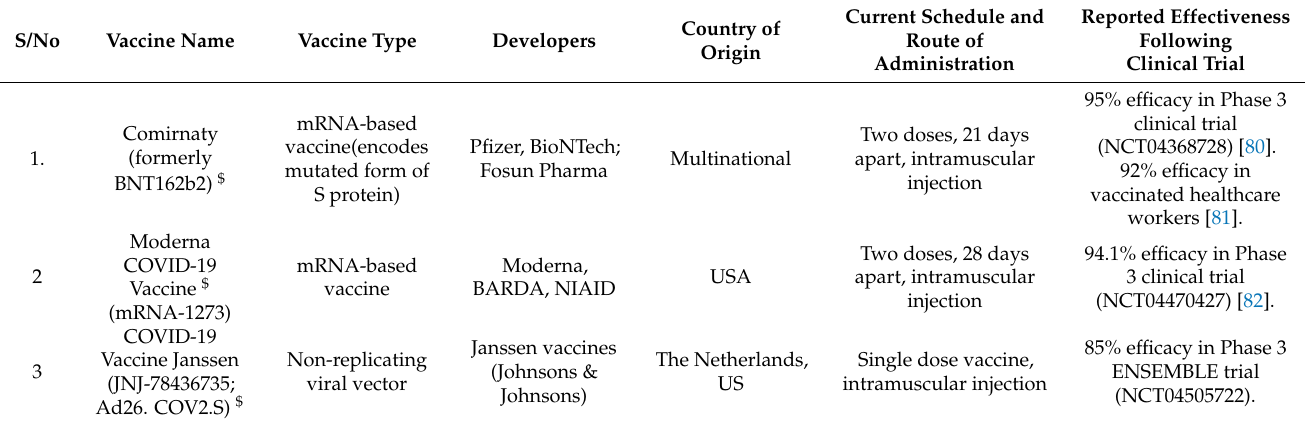
Table 3. List of authorized/approved vaccines against SARS-CoV-2 for COVID-19 ( $ FDA Approved, Emergency Use Authorization (EUA)